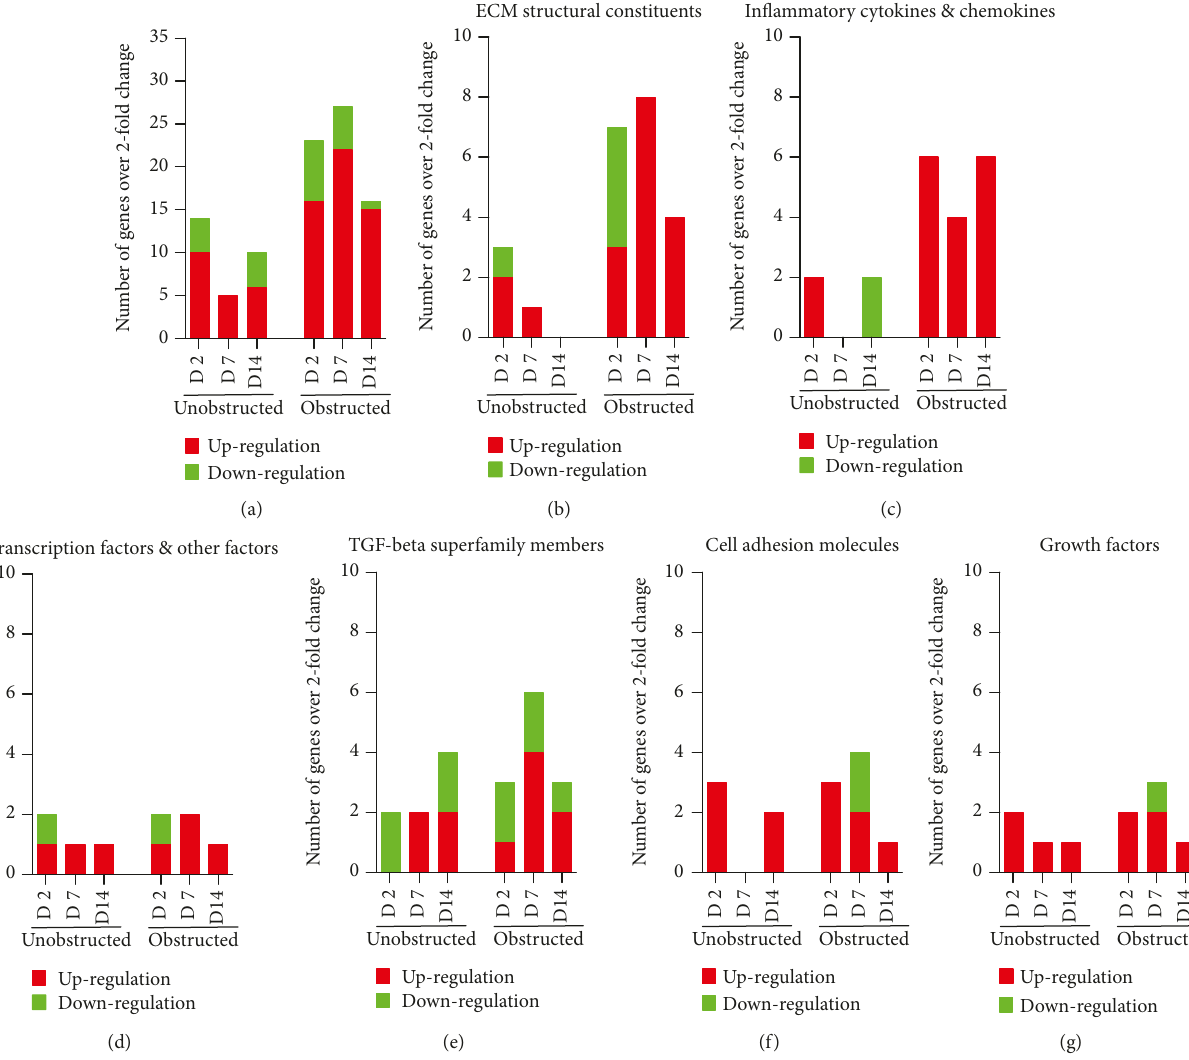
Figure 6: The number and pattern of fi brosis genes that up- and downregulated over 2-fold in the ex vivo expanded cells from renal tissues. (a) Total numbers of genes that up- and downregulated over 2-fold in the twice-passaged MSLCs of the unobstructed and obstructed groups when comparing to the sham group. According to the biological functions, these genes with over 2-fold change are also categorized into ECM structural constituents and remodeling enzymes (b), in fl ammatory cytokines and chemokines (c), transcription factors and other factors (d), TGF-beta superfamily members (e), cell adhesion molecules (f), and growth factors